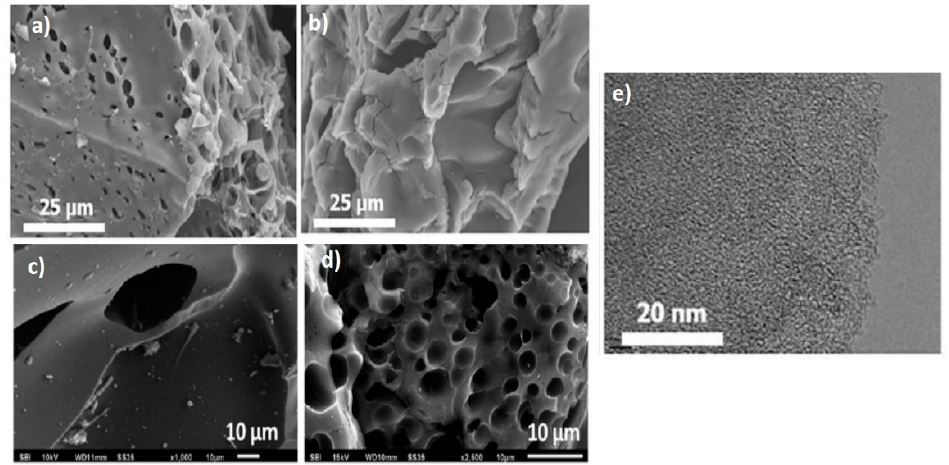
Figure 2. SEM images of ( a ) modified PET-AC with KOH at 700 °C, ( b ) modified PET-AC with KOH at 1000 °C, ( c ) carbonized PET-AC at 700 °C, and ( d ) modified PET-AC with KOH at 700 °C. TEM images of ( e ) modified PET-AC with KOH at 700 °C. (Adapted from Yuan et al. [18] and Kaur et al. [19] with permission from Elsevier).